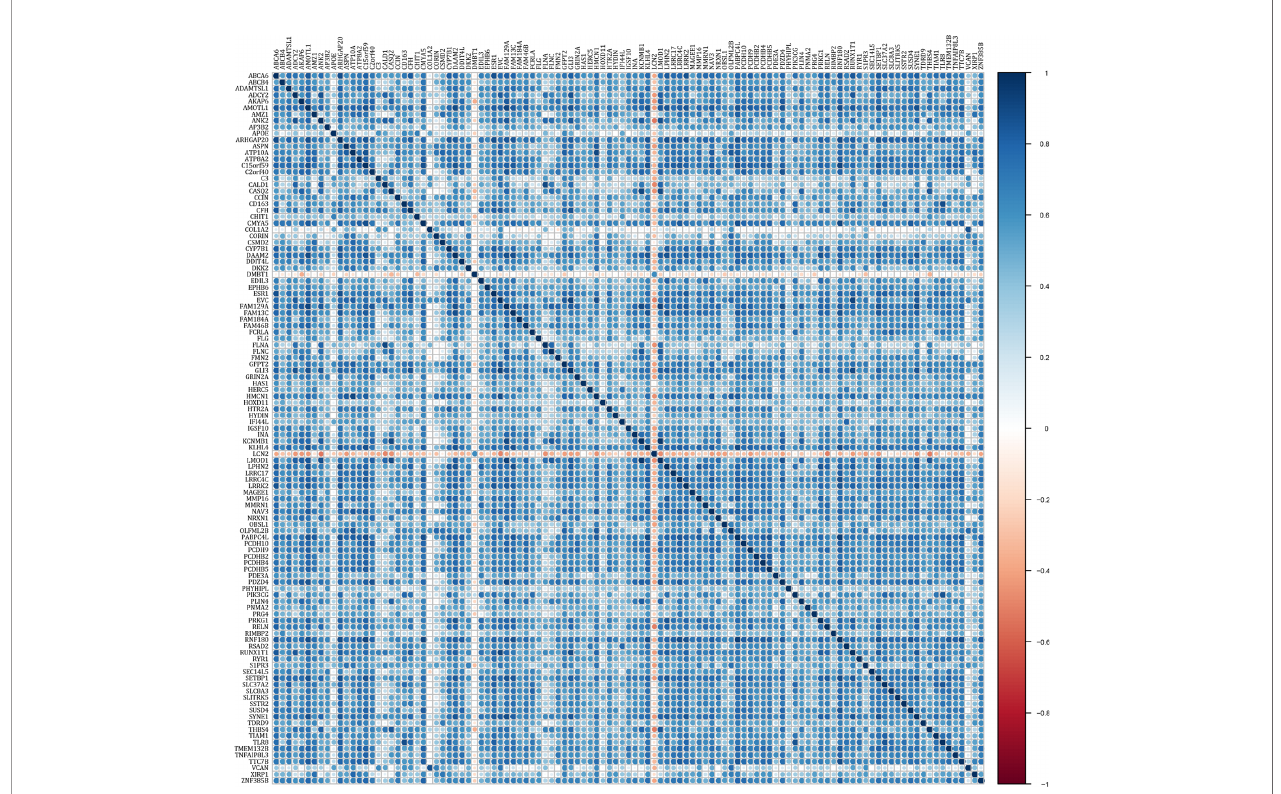
FIGURE 6 | Expression correlation of genes correlated with prognosis of rectal